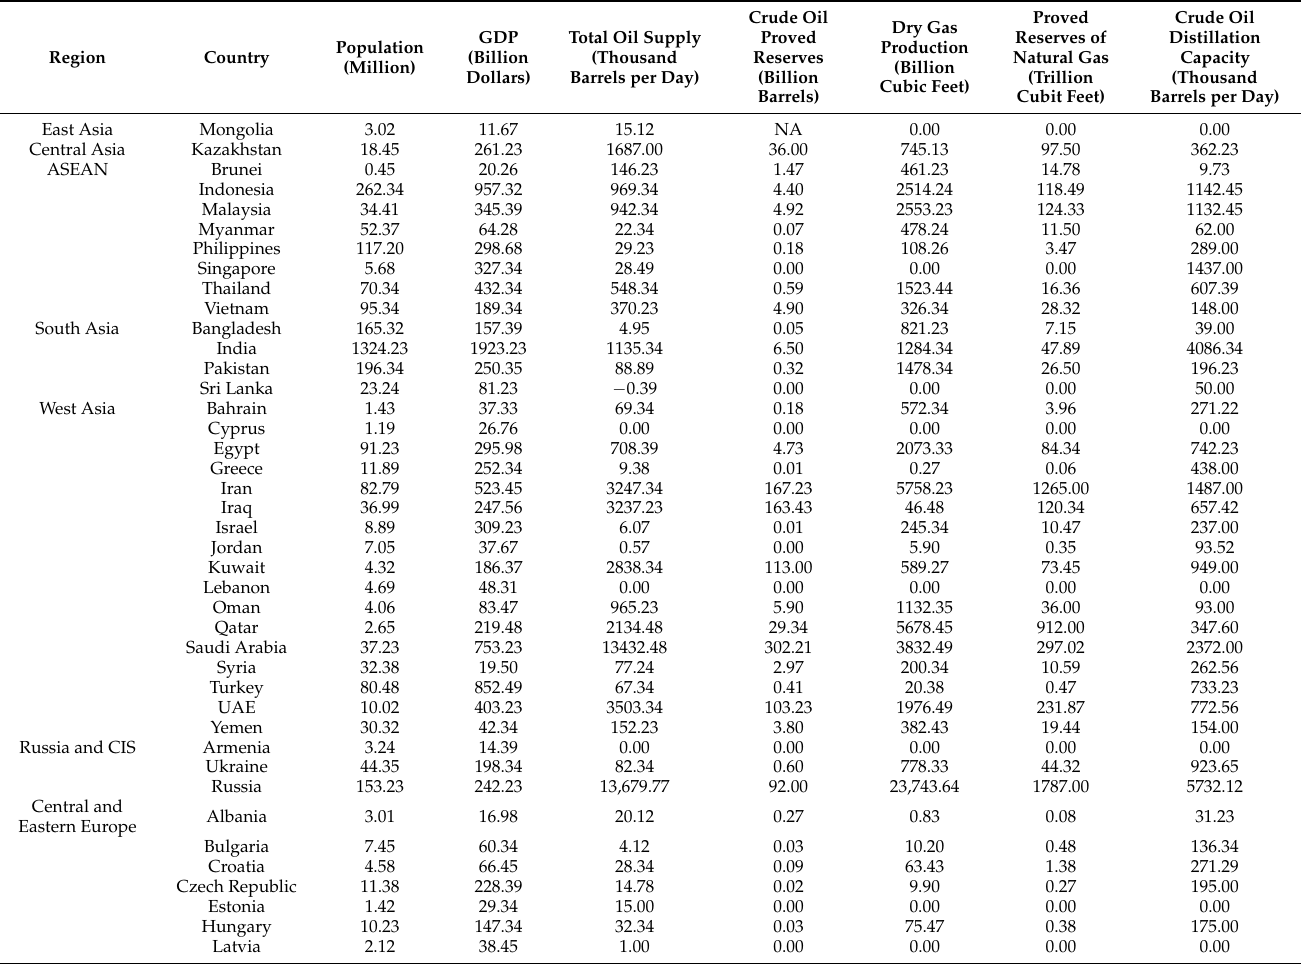
Table A6. Main statistics of 50 Nations alongside the China’s “Belt & Road Initiative in 2018”.